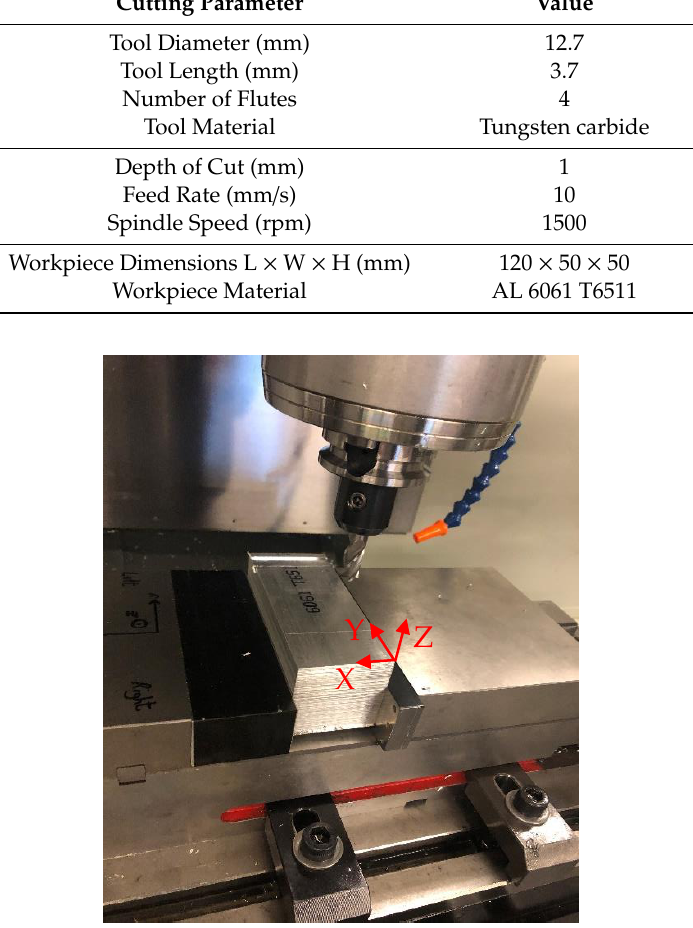
Figure 17. Milling test